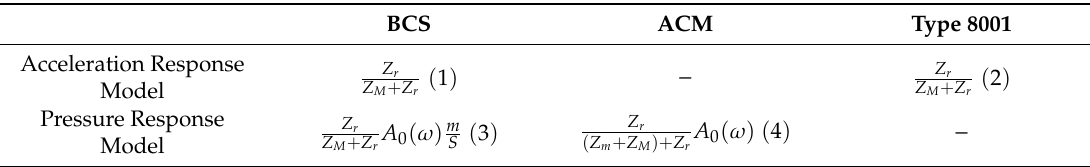
Table 2. Theoretical formula of sensors.